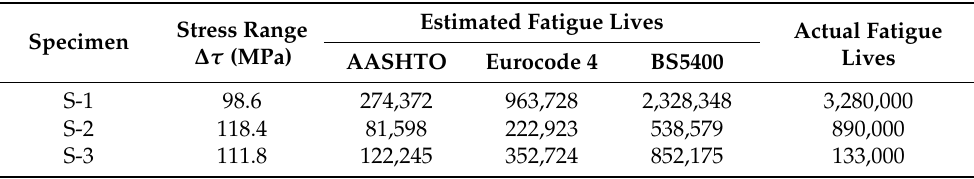
Table 3. Actual and estimated fatigue lives for push-out tests.